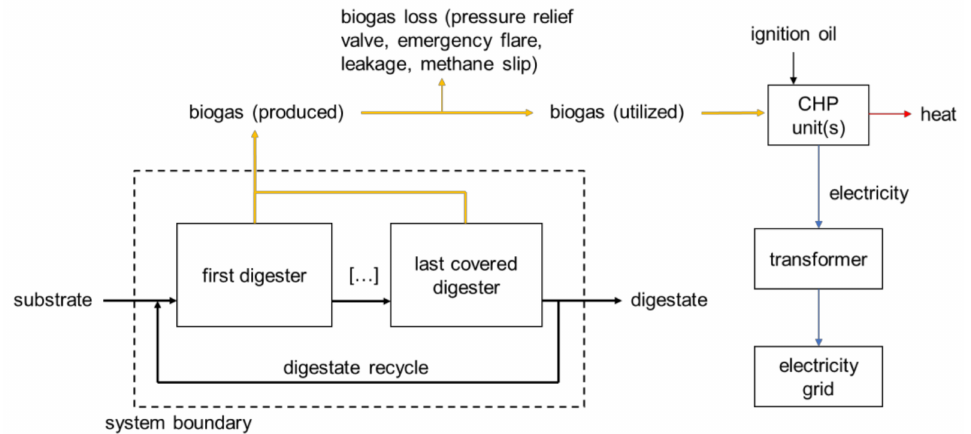
Figure 1. System boundary for efficiency assessment; starting with the first digester and ending with the last covered digester (CHP—combined heat and power